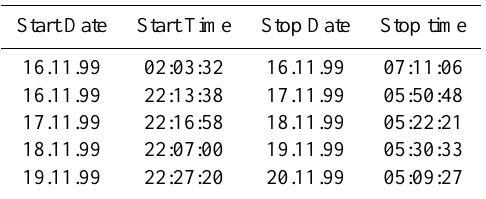
Table 1. Date and time of Leonid Meteor Shower (LMS) observa- tion using Indian MST